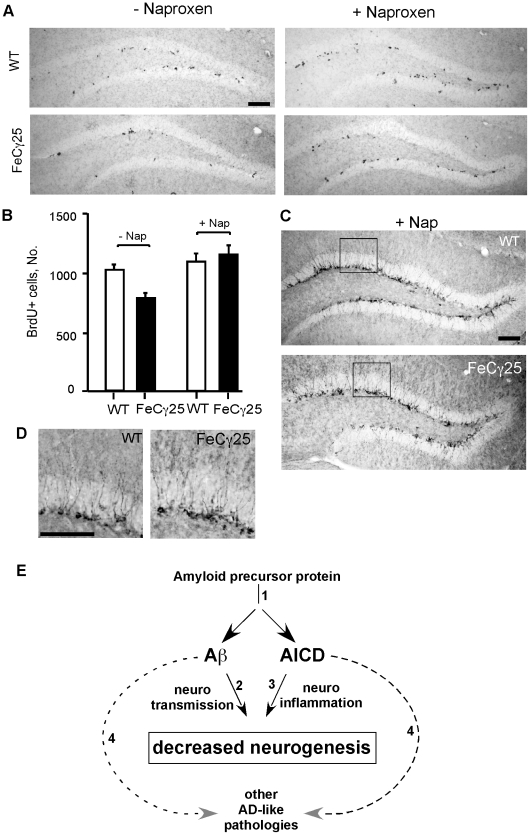
Naproxen treatment also rescued defective adult neurogenesis.
A–B, Naproxen treatment rescued decreased adult hippocampal cell proliferation in FeCγ25 mice at 3 months, quantified in B. C–D, The number of immature neurons detected by doublecortin immunoreactivity was also increased in FeCγ25 mice (bottom) compared to wild-type mice (top) after naproxen treatment. Comparable hippocampal regions are identified in box C and enlarged in D for wild-type (left) and FeCγ25 mice (right). Error bars represent S.E.M. Scale bar  = 100 µm. n = 4 for WT, FeCγ25 and WT with naproxen and n = 6 for FeCγ25 with naproxen. E. A schematics of how amyloidogenic processing of APP could bring about deleterious effects via both AICD and Aβ peptides. Amyloidogenic processing [1] of APP generates Aβ and promotes AICD signaling [45]. Aβ peptides impair adult neurogenesis possibly by causing [2] an imbalance in GABAergic and Glutamatergic transmissions [10] whereas AICD does so by inducing [3] neuroinflammation (this study). Multiple studies have also shown that both Aβ and AICD peptide fragments cause [4] other AD-pathological (including tau hyperphosphorylation, neuronal cell loss, silent seizures, memory deficits) features in mice (dashed arrows).